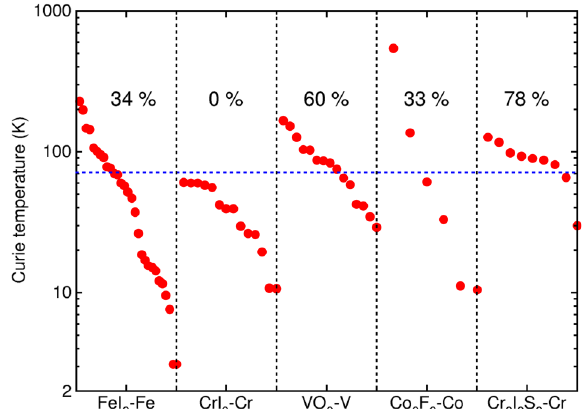
Fig. 2 The distribution of T C for 73 2DFM materials in different structure prototypes. The T C s are arranged in descending order. Blue dot line marks the average T C for the 73 structures. The percentages are the ratios of structures that have T C above the average Curie temperature for each category.